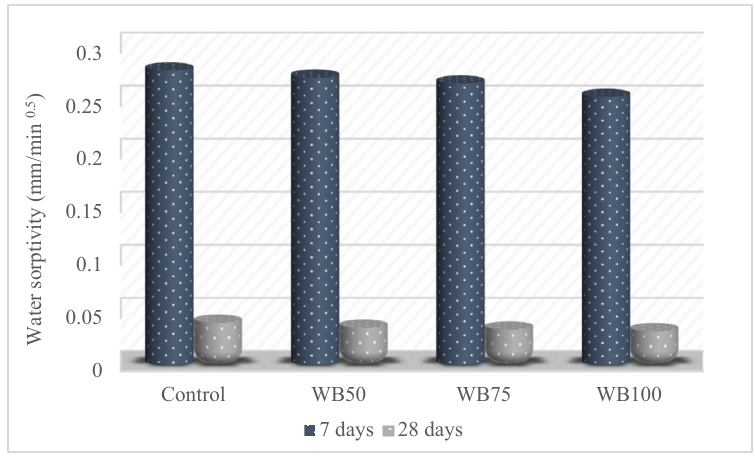
Figure 6. Capillary water absorption of mixtures.